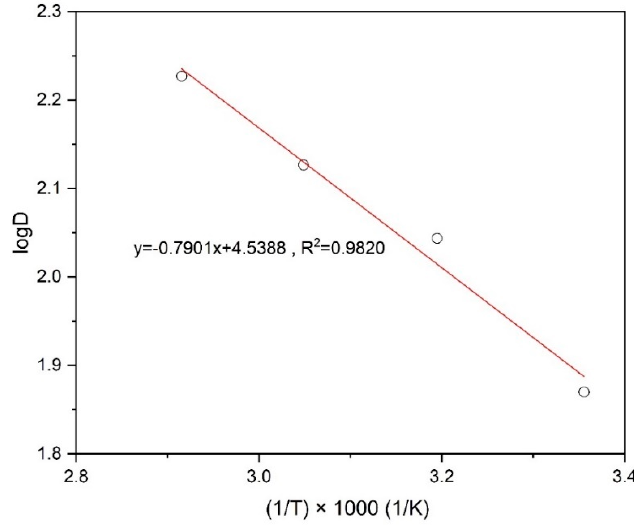
Figure 11. Plot of log D against 1000/T for the extraction of Cu using Mextral 5640H.